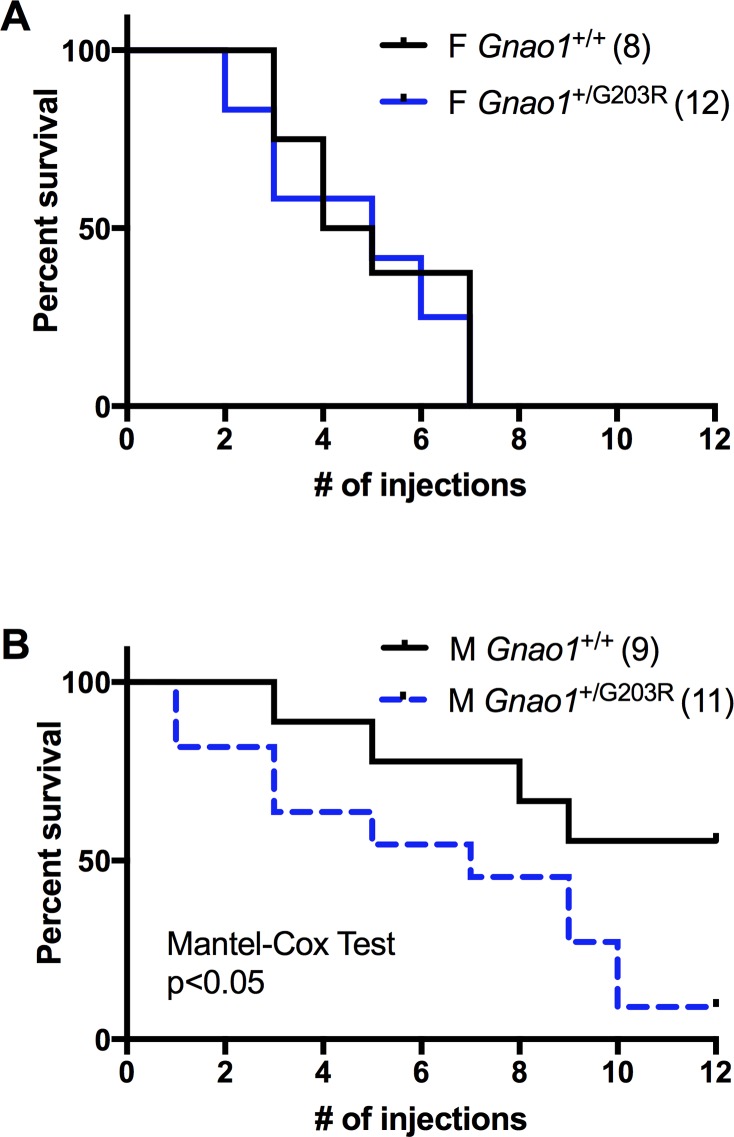
Gnao1+/G203R male mice have an enhanced Pentylenetetrazol (PTZ) kindling response.(A) Female Gnao1+/G203R mice did not show heightened sensitivity to PTZ injection. (B) Male Gnao1+/G203R mice developed seizures earlier than WT littermates after repeated PTZ injections (Mantel-Cox Test; p<0.05).